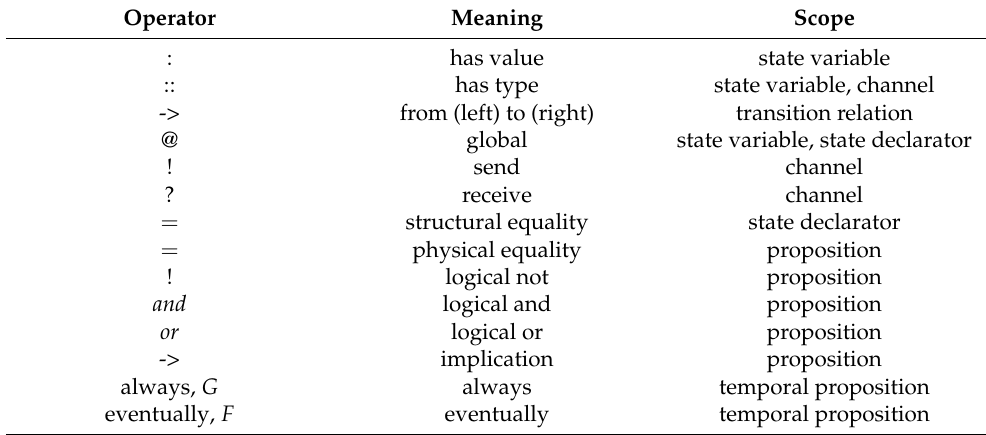
Table A1. Operators in the Seniz